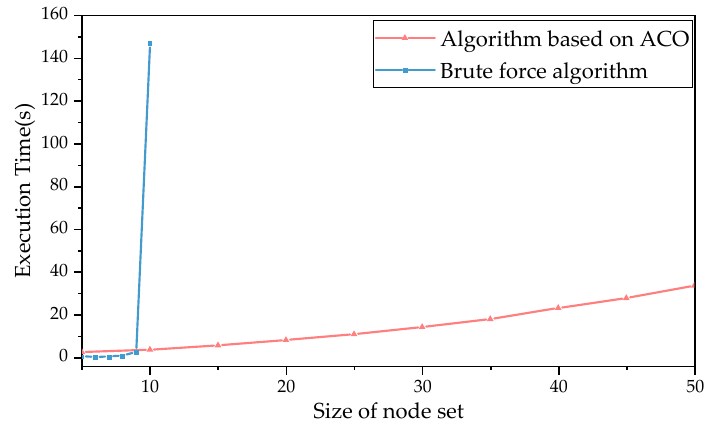
Figure 13. The execution time of the objective function with increasing N values with the brute force